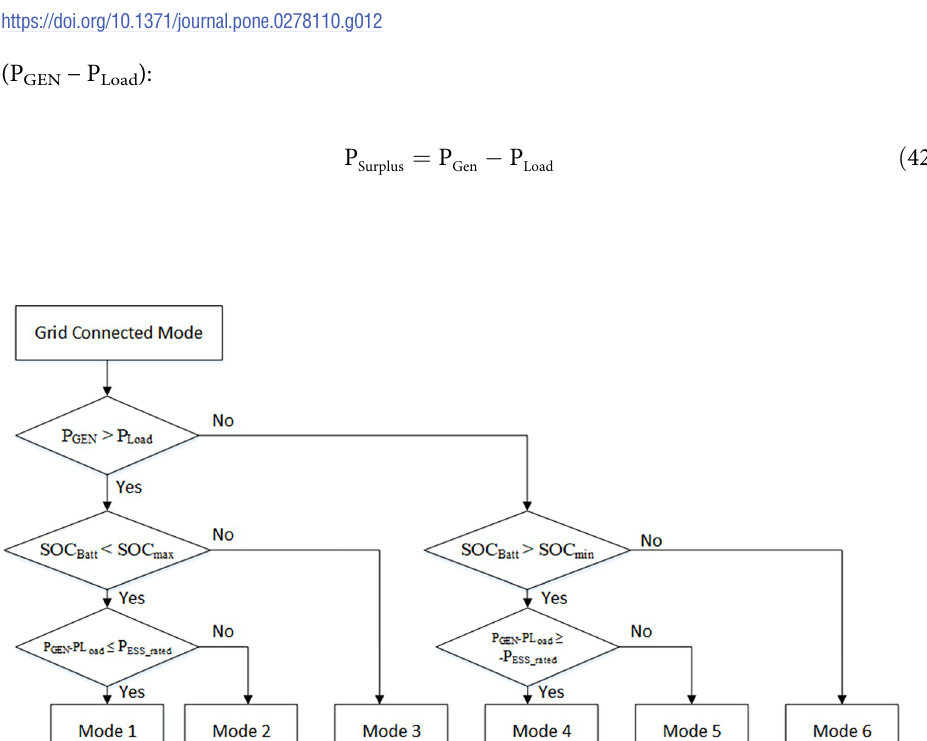
Fig 12. Flow diagram of branch and bound algorithm.